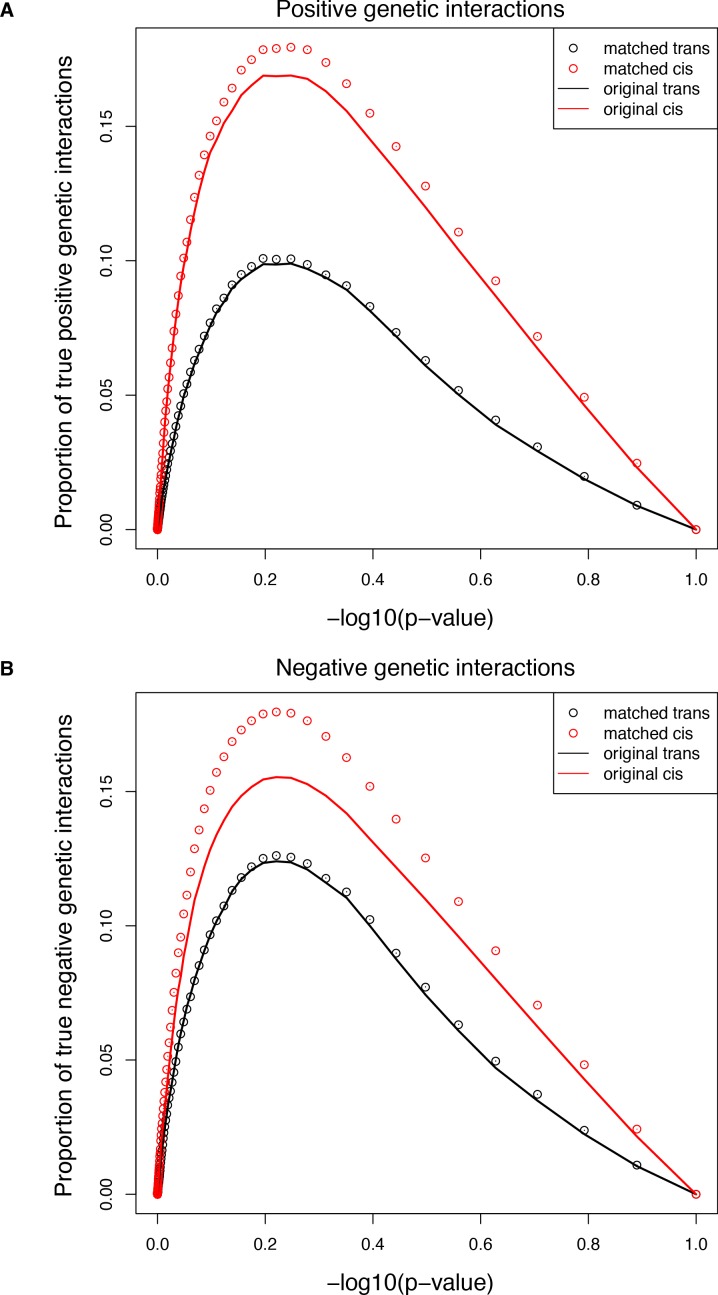
Comparisons of the extent of structural genetic interactions in cis and trans.(A–B) Proportion of true positive (A) or negative (B) genetic interactions in the original (solid lines) or sub-sampled (open circles) libraries at different p-value cut-offs, showing that the higher prevalence of both positive and negative interactions in the cis library is not the consequence of the different distribution of single mutants effects. Error bars represent 95% confidence intervals around the mean of the 1000 sub-samplings. True interactions are calculated as the total number of interactions called significant at a given p-value threshold multiplied by the true discovery rate (1-FDR) corresponding to that p-value threshold in that library.